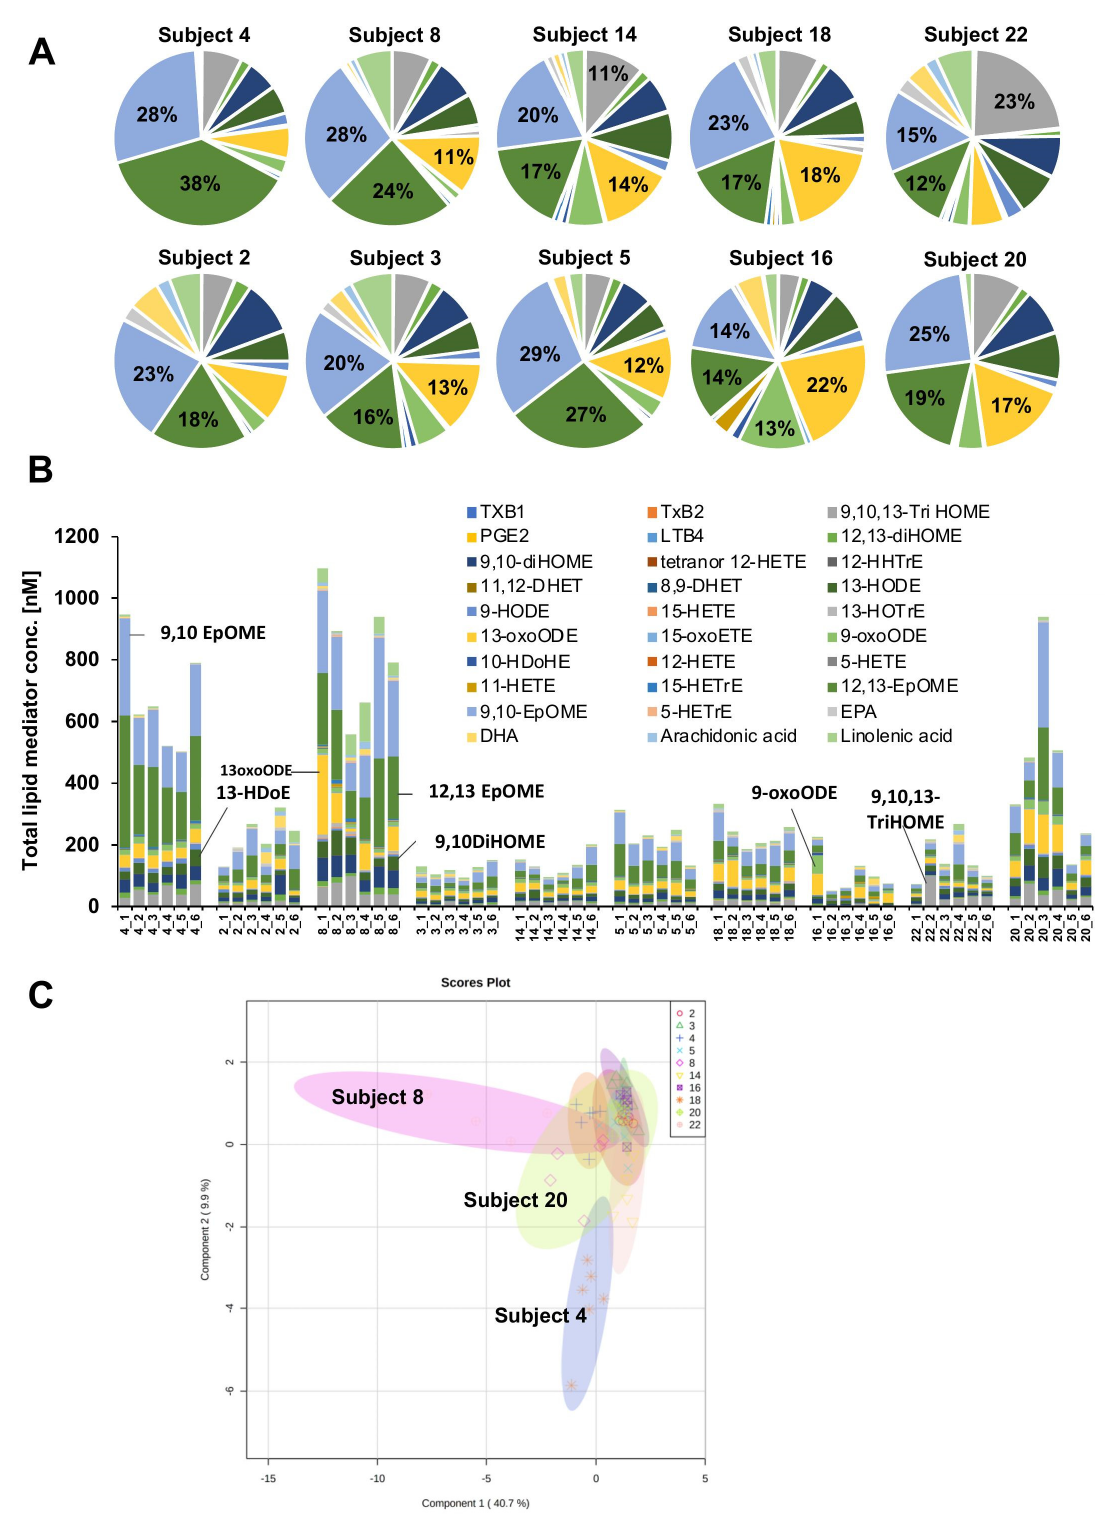
Figure 3. Comparative quantification of lipid mediators in the cheek samples by targeted lipidomics. ( A ) Pie charts showing total lipid mediators detected on the skin of individual subjects and their proportional distribution. The percentage of lipid mediators is only indicated for species that are represented by at least 10%. ( B ) Stacked bar charts show concentrations of lipid mediators that were quantified on the indicated 6 consecutive days, grouped by subjects. ( C ) sPLS-DA comparing lipid mediator concentrations between different subjects. 95% confidence region is shown for each sample group. Only the most distinct subjects are